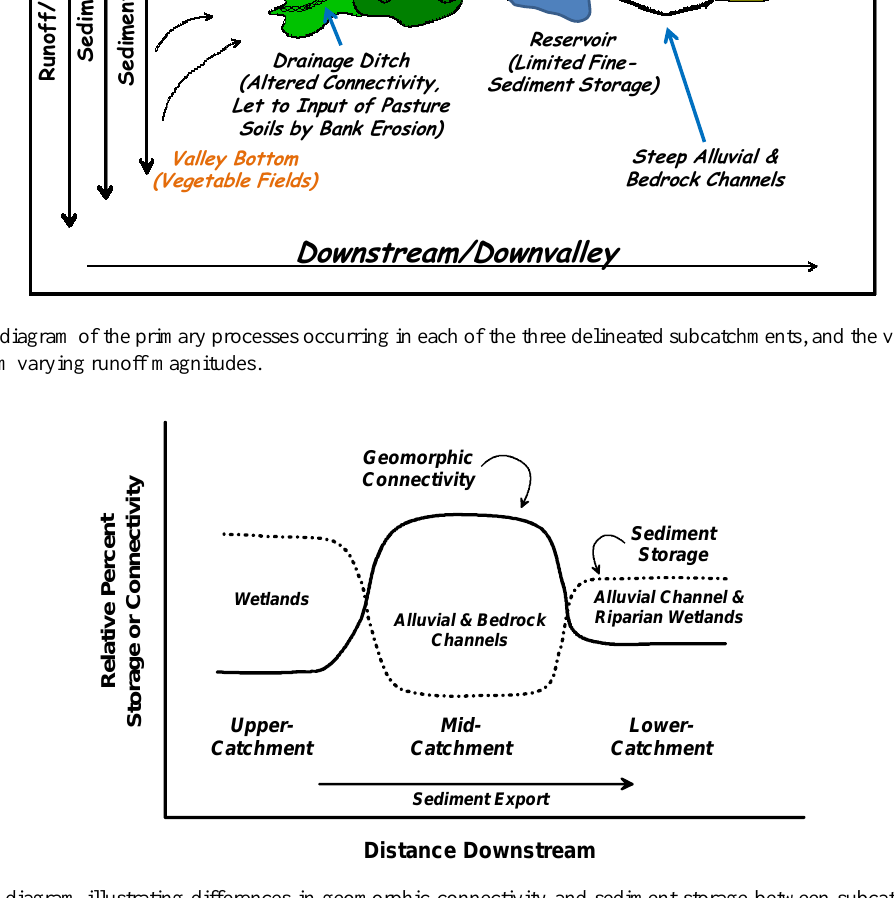
Fig. 14. Schematic diagram illustrating differences in geomorphic connectivity and sediment storage between subcatchment zones of the Mkabela